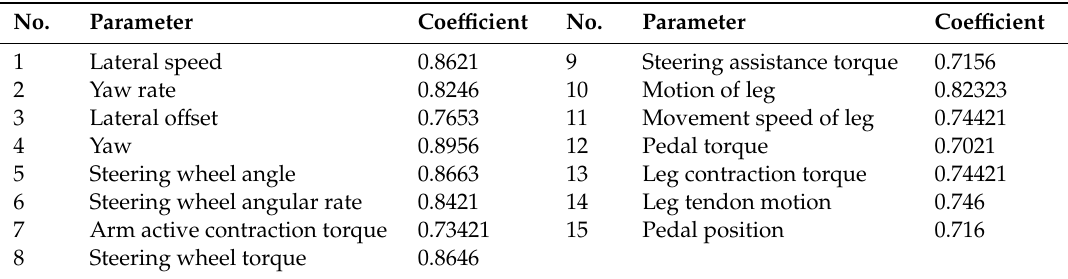
Table 5. Covariance analysis results between the actual value and Unscented Kalman Filter (UKF) estimated value.